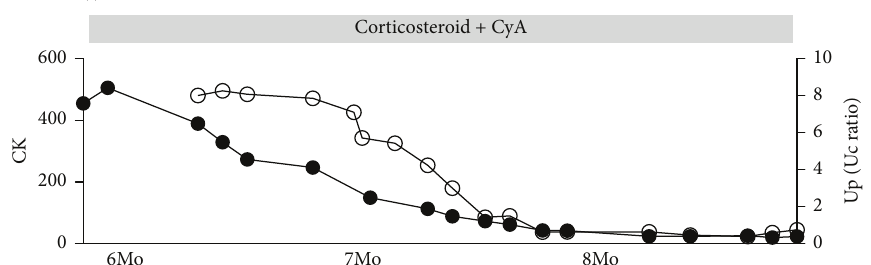
Figure 4: Graph showing serum levels of creatine kinase (CK) and urine protein-to-creatinine ratio (Up/Uc ratio) over time after second admission to our hospital. The left vertical axis indicates the serum CK levels ((U/L), closed black circles), and the right axis indicates the degree of proteinuria, expressed as (Up/Uc) ratio (open circles). The horizontal line indicates the months (Mo) after discharge of first admission. Up: urinary protein; Uc: urinary creatinine. ∗∗ indicates readmission to our hospital. CyA: cyclosporine